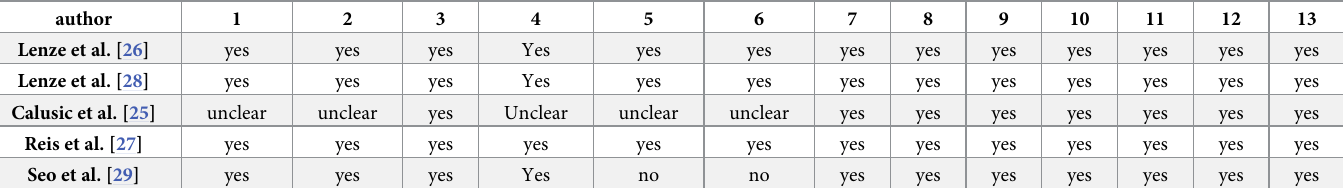
Table 4. Quality assessment of the clinical